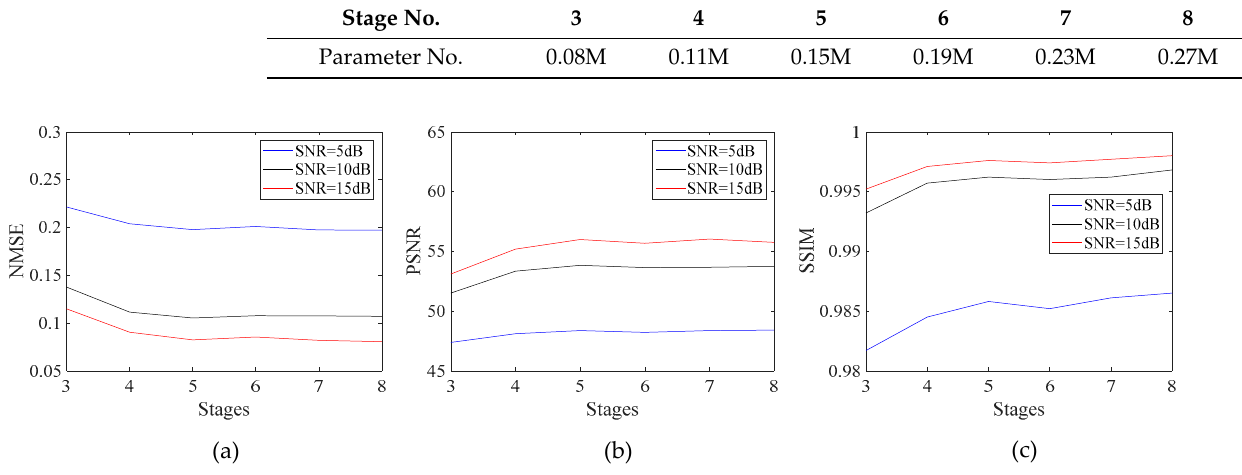
Figure 11. Variation of ( a ) NMSE, ( b ) PSNR, and ( c ) SSIM with the number of stages.